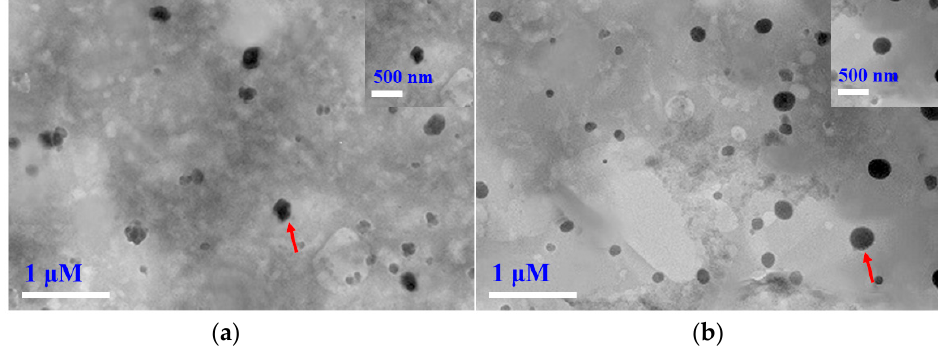
Figure 4. TEM analysis of Car-SLNs prepared with a carvacrol loading at 30% mass of lipids and a PGMP:GMS mass ratio of 2:1 ( a ) or 1:1 ( b ). The particles shown in insert images were pointed by red arrows.